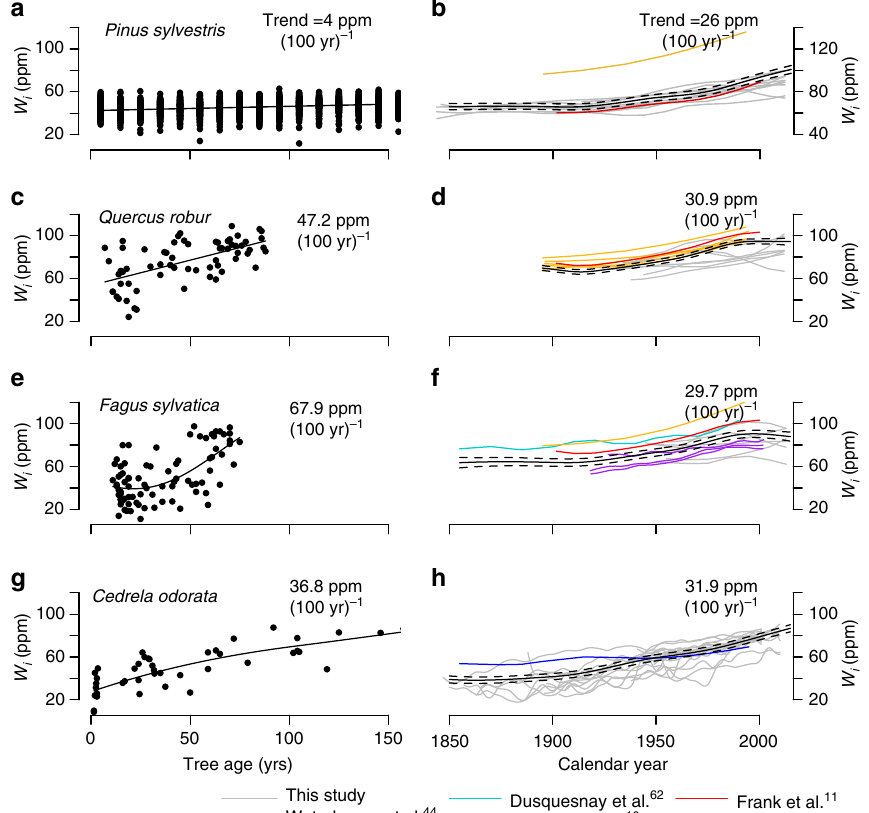
Fig. 1 Developmental trends and time trends of intrinsic water use ef fi ciency for four species derived from tree ring carbon isotopes. Developmental trends ( a , c , e and g ) are controlled for variation in CO 2 by using sub-fossil trees growing under relatively constant pre-industrial CO 2 (for Pinus ), or by plotting W i derived from the fi ve outermost rings across a range of trees differing in tree age (for Quercus , Fagus and Cedrela ). Time trends ( b , d , f and h ) are reconstructed based on classic tree ring approaches, which infer past change in W i using pooled or individual tree ring δ 13 C series derived from big trees when these were younger and smaller, thus assuming negligible developmental effects. The data for Pinus consist of 10-year time series from 182 sub-fossil trees (5630 BP – AD 1930) from northern Fennoscandia (Helama et al. 39 ). Time trends in W i are estimated using published trends ( coloured lines ), complemented with new data collected from dominant trees in this study ( grey lines , see Methods section). Black lines show mean trend estimates using general additive mixed models ( GAMM ) with standard errors ( broken lines ). Long-term linear W i trends were estimated using linear mixed-effects models with weighting for sampling intensity for each study (see Methods section). Note that we excluded trees with size lower than 1 m from the age trend analysis here ( a , c , e and g ) to avoid in fl uence of soil-respired carbon. Included literature data are from Frank et al. 11 , red , Waterhouse et al. 46 , yellow , Duquesnay et al. 62 , cyan , Penuelas et al. 10 , purple and Hietz et al. 45 , blue (for details see Supplementary Table